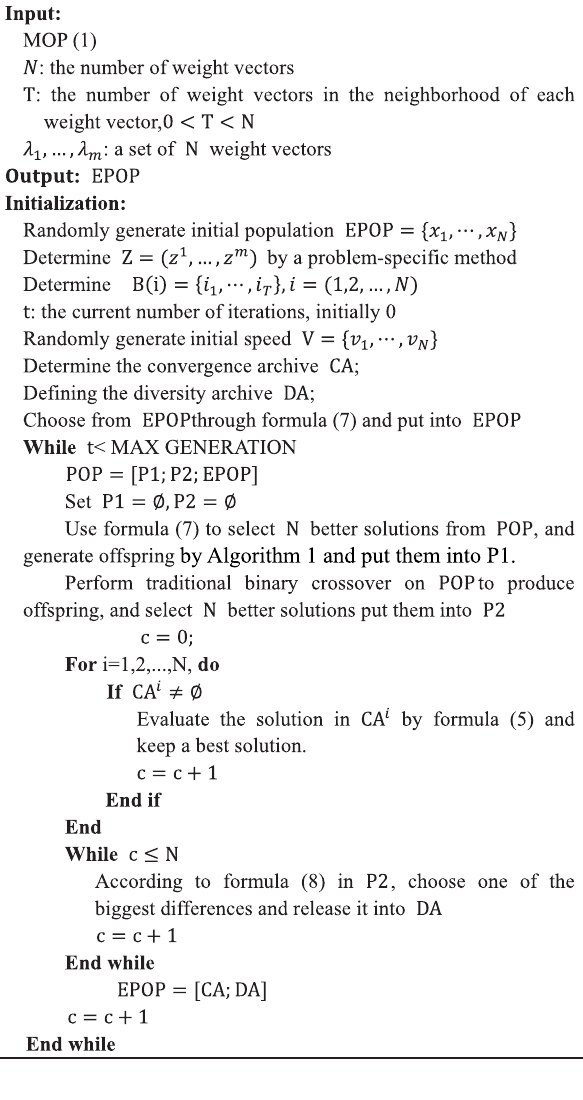
Algorithm 2. Proposed algorithm framework.